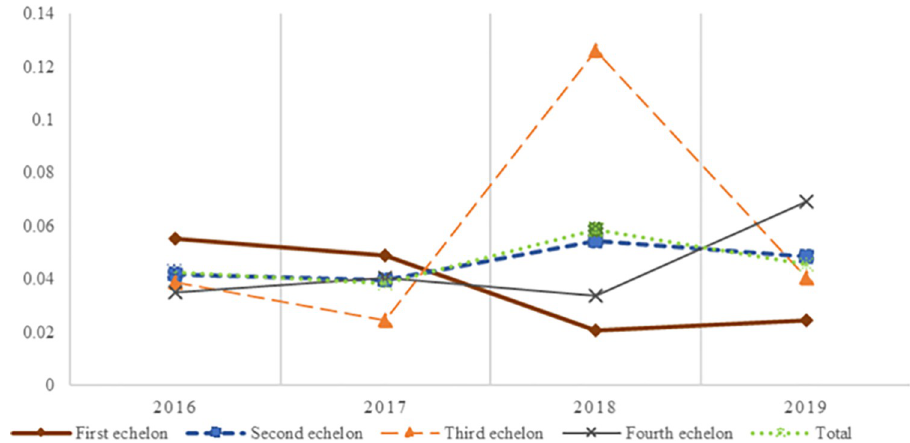
Fig 4. The CCD development trends of the